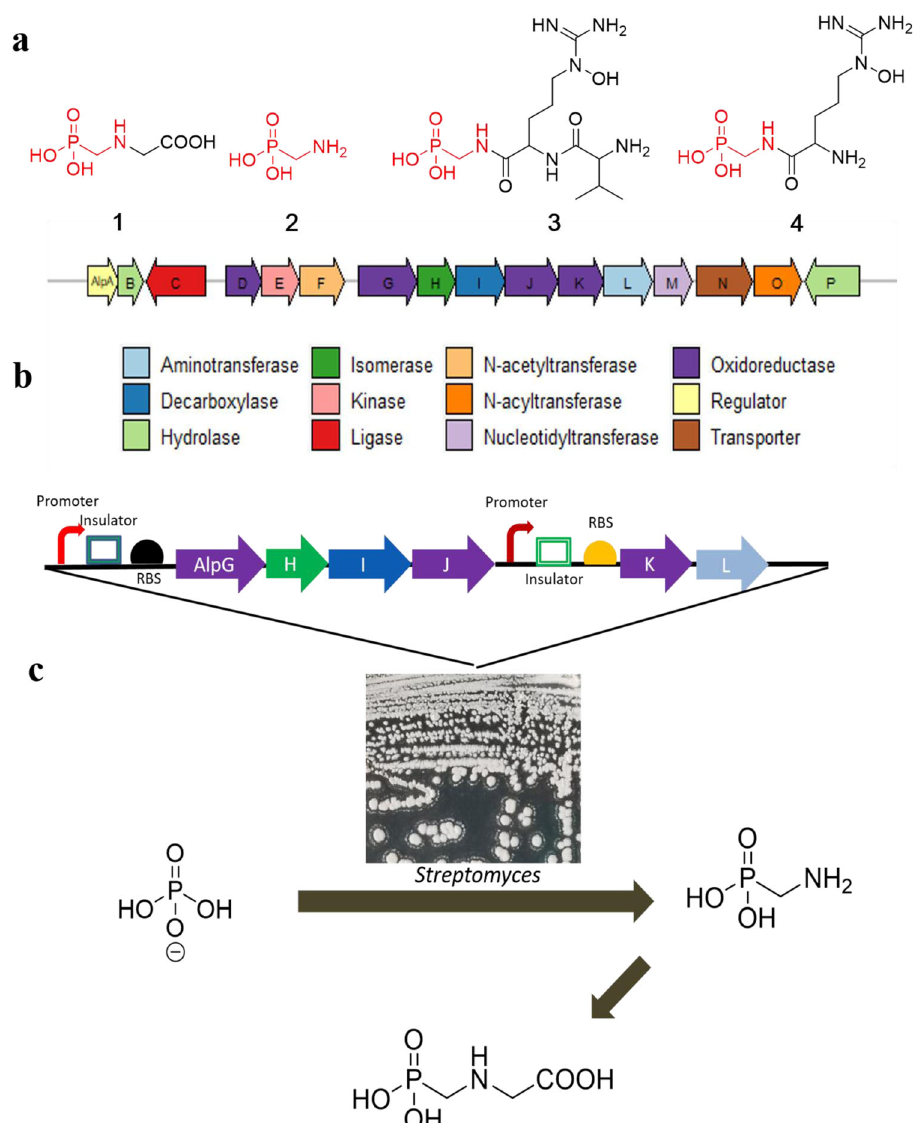
Fig. 1 A synthetic biology-based semisynthesis of the herbicide glyphosate (1). a Chemical structures of glyphosate ( 1 ), aminomethylphosphonate (AMP) ( 2 ), argolaphos A ( 3 ), and argolaphos B ( 4 ). b DNA fragments from S. monomycini NRRL B-24309 that contain the gene alpH , the homolog of pepM gene. Genes are color-coded according to their putative function according to the analysis in Table 1. c The work fl ow of the synthetic biology strategy used to produce 1 from inorganic